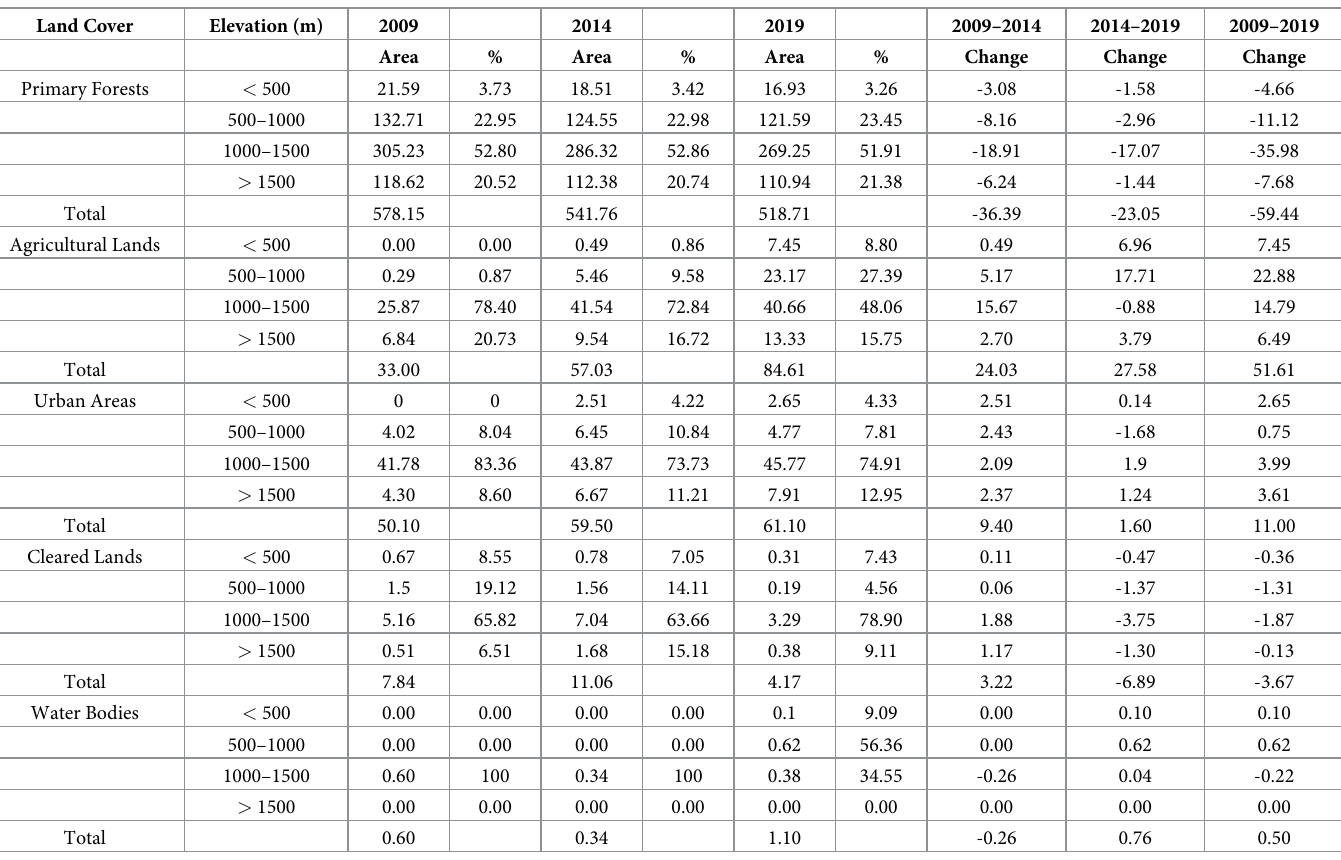
Table 5. LU/LC distribution of area and area change (km 2 ) across the elevation (m). Land